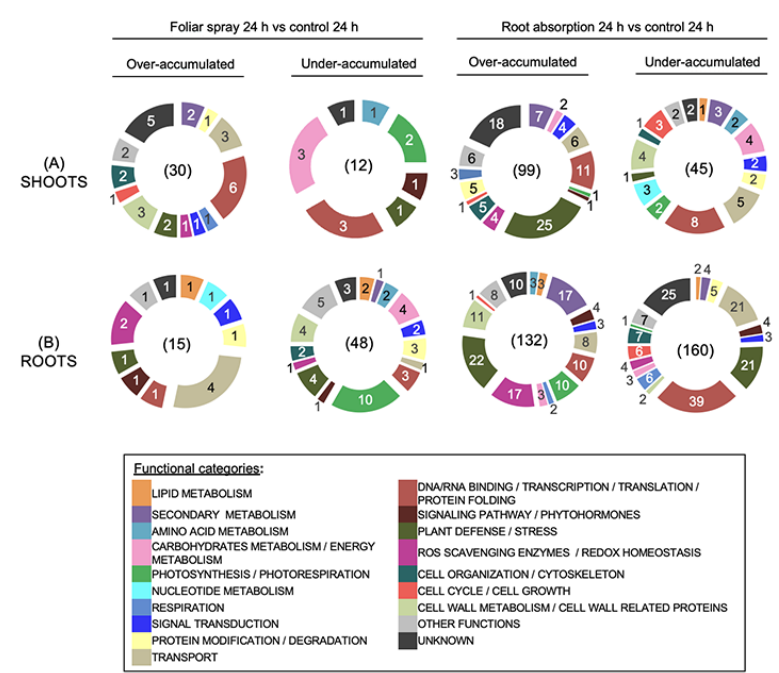
Figure 4. Functional classification of differentially accumulated proteins (DAPs) in shoots ( A ) and roots ( B ) of B. napus var. Darmor- bzh treated with RLs by foliar spray or root absorption versus control during 24 h. The protein families are assigned based on the information available in the Uniprot and Gene Ontology databases and reclassified according to the literature information. These experiments were performed on three biological replicates.